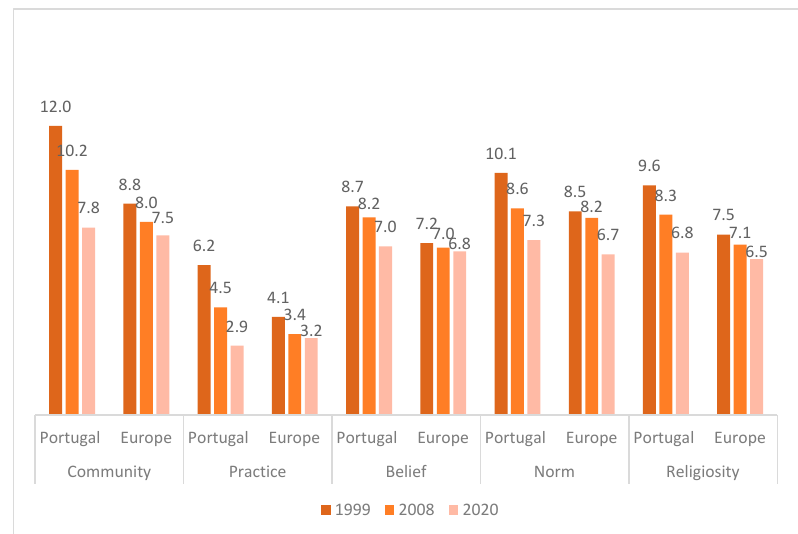
Figure 6. Indexes of Portugal and Europe by round in youth. Source: EVS (2021). Notes: Indexes (Portugal/Europe) vary between 0 and 16. Significant differences exist between all rounds with the following exceptions: in practice in Europe, there are no significant differences between 2008 and 2020; in belief in Portugal and norm in Europe, there are no significant differences between 1999 and 2008; in belief in Europe, there are significant differences only between 1999 and 2020. Tests: Community—Portugal—Fw (2) = 44.514, p < 0.001; Europe—F (2) = 37.391, p < 0.001. Practice—Portugal—Fw (2) = 25.977, p < 0.001; Europe—Fw (2) = 20.667, p < 0.001. Belief—Portugal—Fw (2) = 8.350, p < 0.001; Europe—Fw (2) = 2.977, p = 0.051. Norm—Portugal—F (2) = 20.121, p < 0.001; Europe—Fw (2) = 76.676, p < 0.001. Religiosity—Portugal—Fw (2) = 37.861, p < 0.001; Europe—Fw (2) = 36.822, p < 0.001. In all, normality assumed, and homogeneity of variances not assumed, except in Community in Europe and Norm in Portugal where they are both